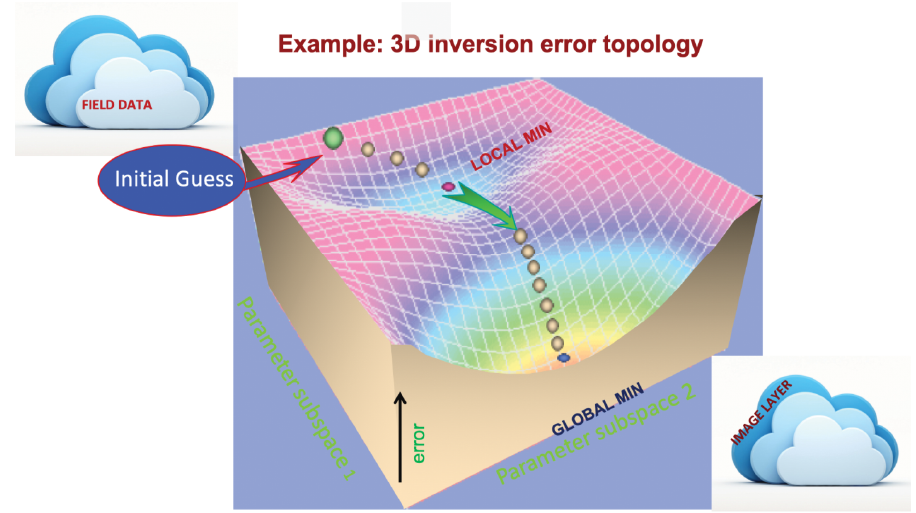
Figure 12. Multi-parameter error surface illustrating how the initial guess model moves around the error surface towards a global solution. If we follow strict convergence criteria it could get stuck around the local minimum. The axis parameter represents only two parameters of the model.